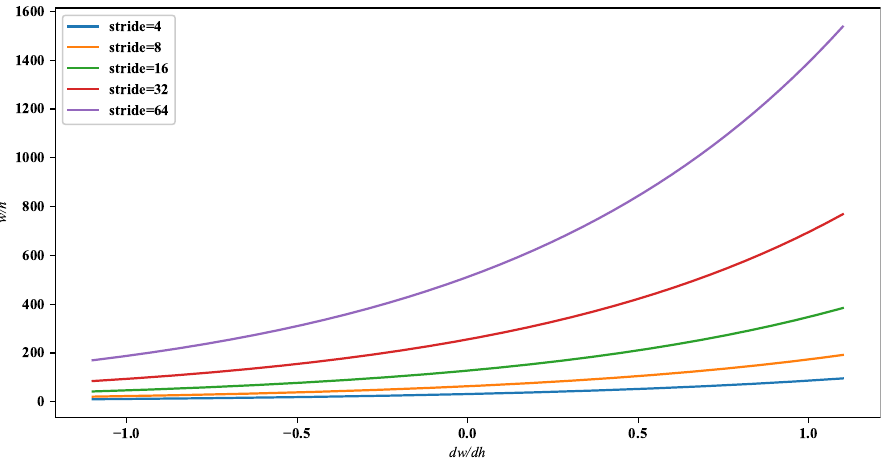
Figure 4. The illustration of the nonlinear function